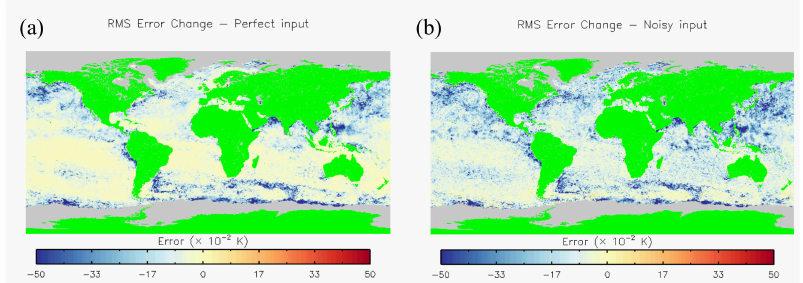
Figure 10. Change in the RMS error of the reconstructed SST field in July from adding CIMR data to the input for: ( a ) perfect input data and ( b ) input data containing realistic